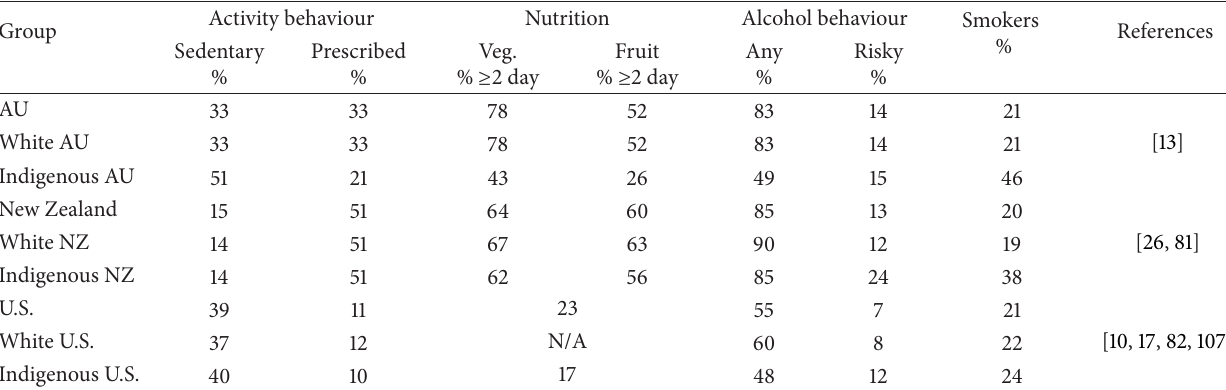
Table 2: Prevalence of modifiable lifestyle risk